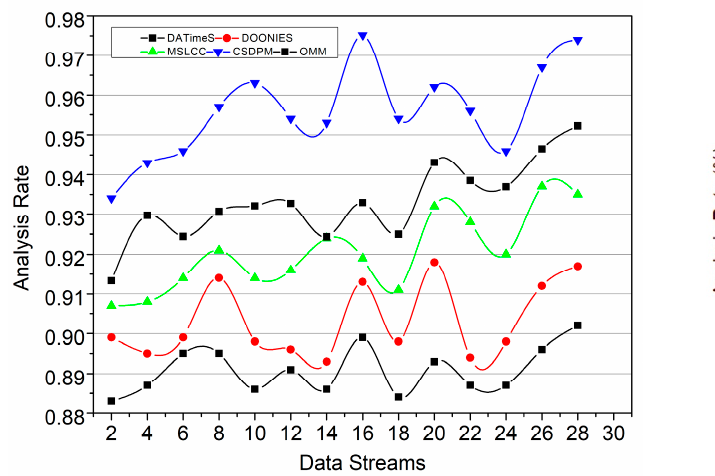
Figure 11. Analysis rate.